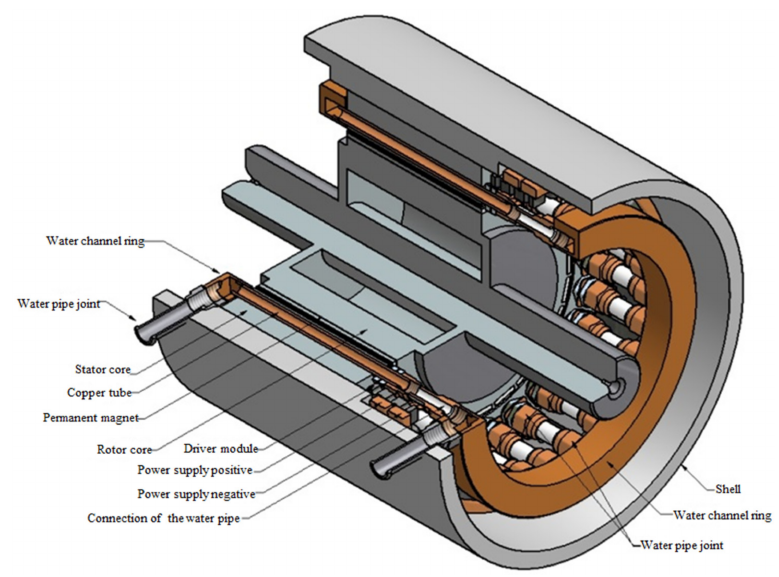
Figure 1. The stator structure of the new type of